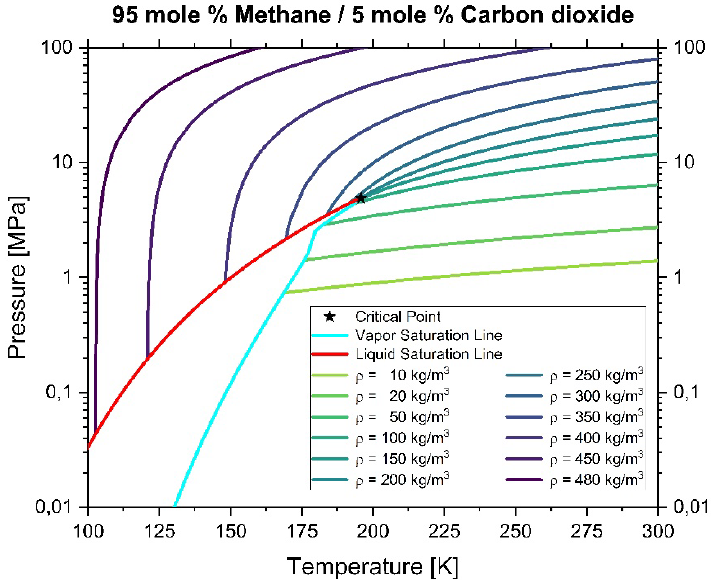
Figure 2. Calculated phase diagram of 95 mole % methane / 5 mole % carbon dioxide for pressures between 0.01 and 100 MPa and temperatures between 100 and 300 K. (Linear temperature scale, logarithmic pressure scale. Vapor saturation line: cyan blue color; liquid saturation line: red color; black star: critical point, densities: other colored